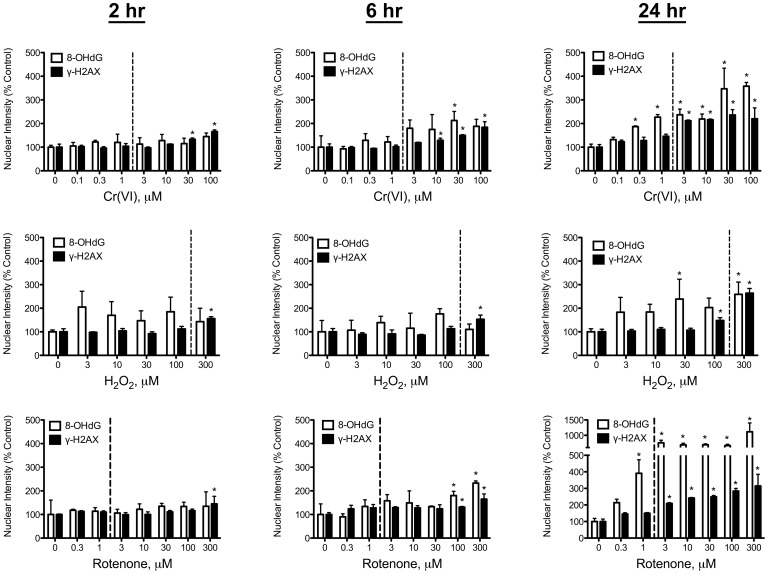
DNA damage in undifferentiated Caco-2.Nuclear staining intensity of 8-OHdG and γ-H2AX in undifferentiated Caco-2 cells. Cells were seeded at density 1×104 cells/100 µl/well, grown for 24 hr, then treated with the indicated concentrations of Cr(VI) (top), hydrogen peroxide (middle) or rotenone (bottom). Nuclear staining intensity was measured after 2, 6, and 24 hours of incubation. Concentrations to the right of the dotted line of each plot were cytotoxic (reduced cell numbers) at 24 hr of exposure. Data are expressed as % Control, and represent mean ±s.d. (n = 3, where n is number of individual replicates). *p<0.05 by ANOVA followed by Dunnett’s test.